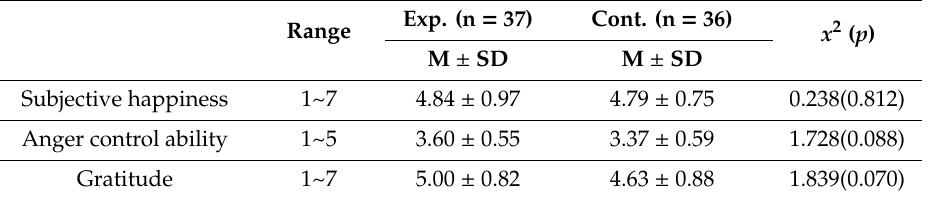
Table 3. Homogeneity test of dependent variables between the two